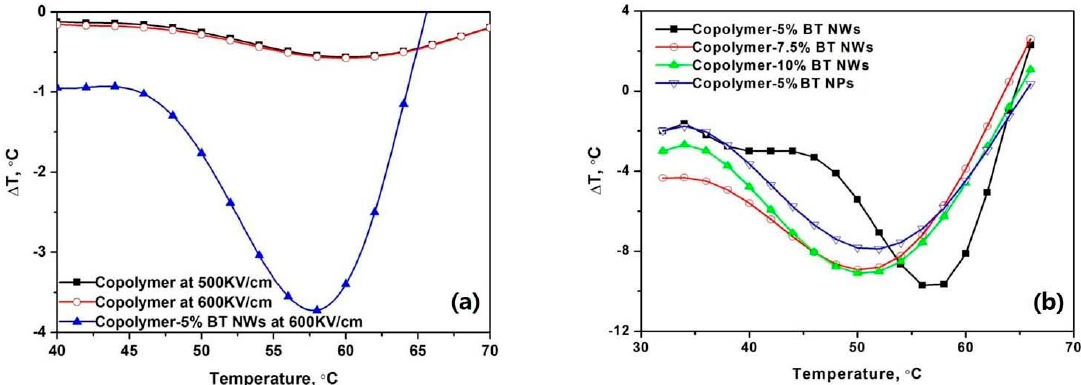
Figure 4. Comparisons on the negative ECEs in ( a ) pristine P(VDF–TrFE) copolymer and the